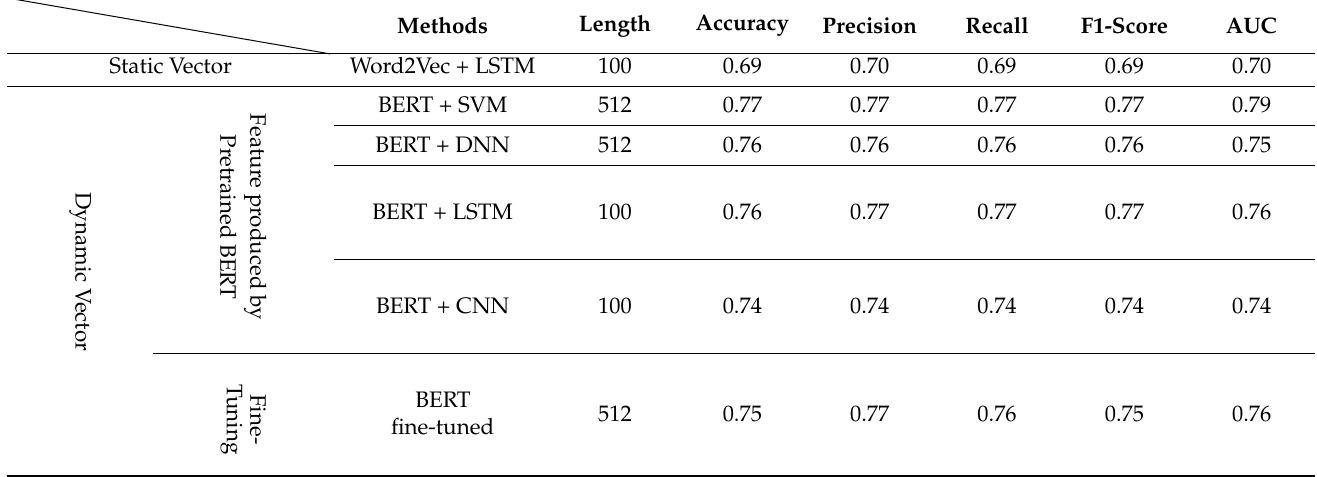
Table 7. Classification results using the combined dataset (Dianping and Samsung).